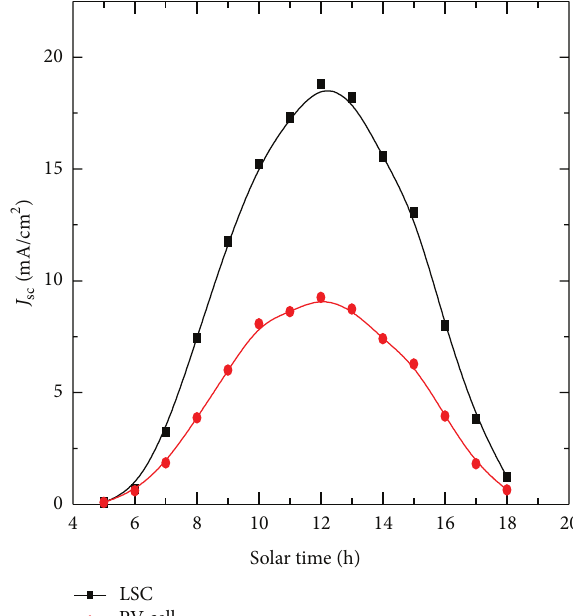
Figure13:Theareaunderthe 𝐽 and plotted in comparison with that of a reference PV cell for all seasons , sc